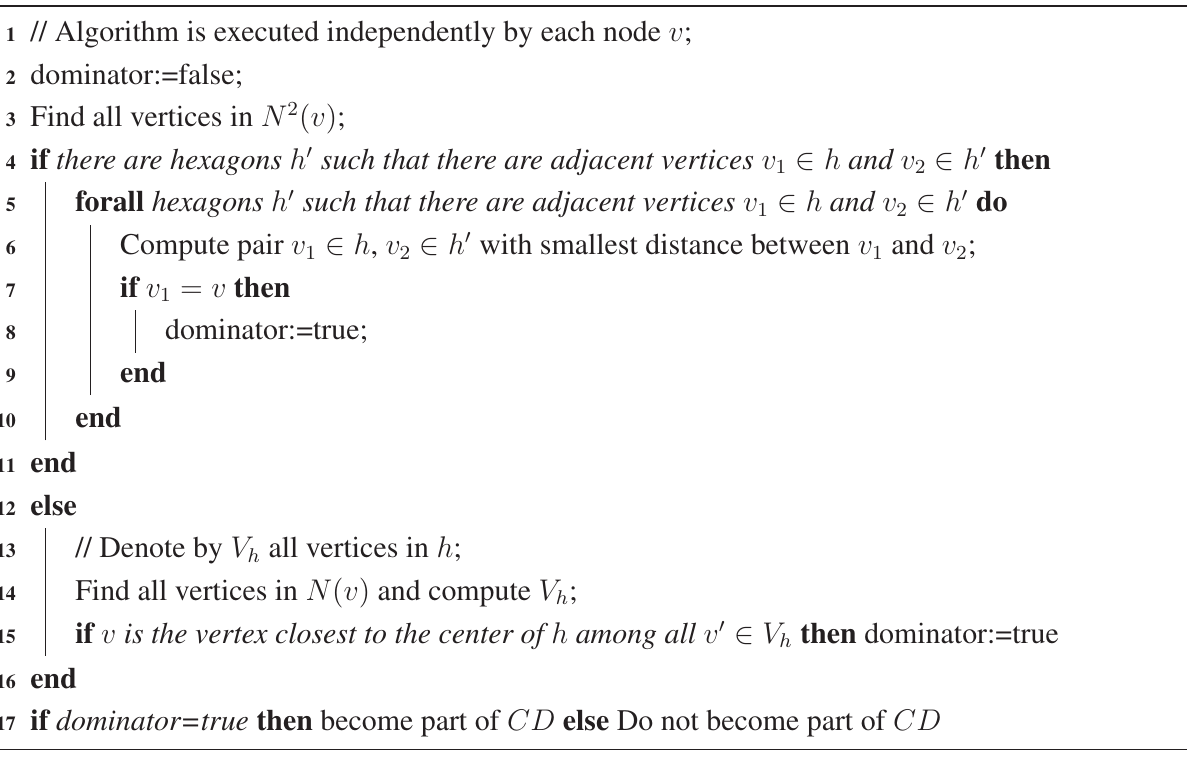
Algorithm 3 : Local algorithm for finding a connected dominating set in a unit disk graph // Algorithm is executed independently by each node v ;